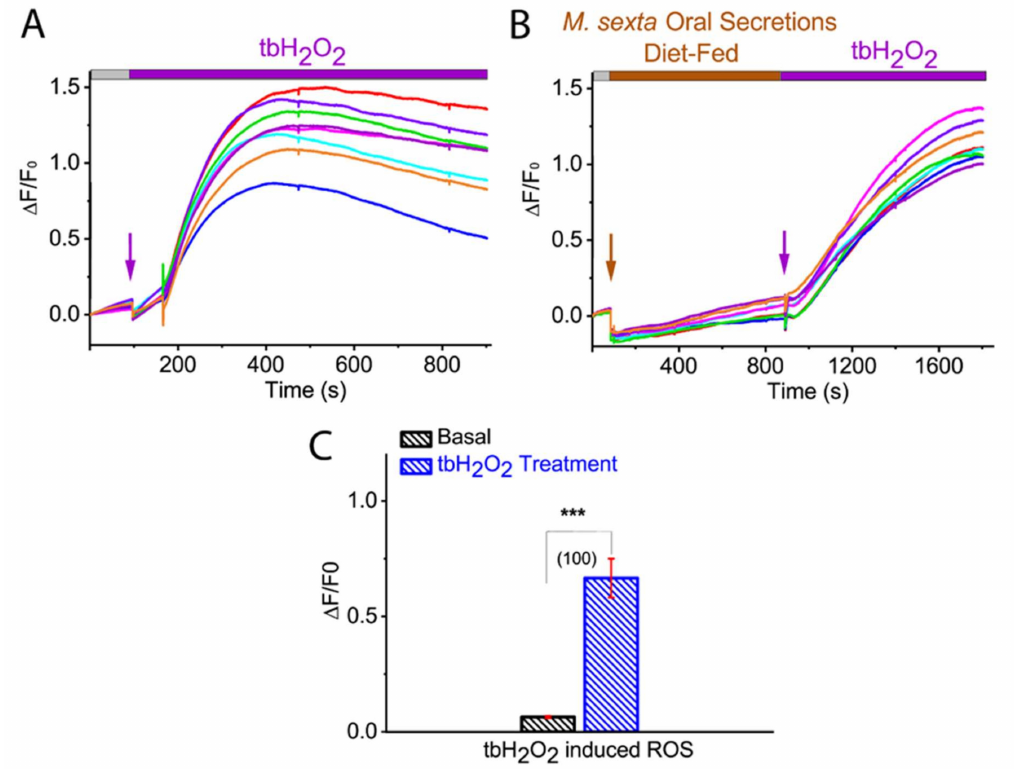
Figure 3. E ff ect of membrane-permeable oxidant tbH 2 O 2 on ROS production in tomato protoplasts. Representative ROS imaging of the isolated tomato protoplast with the application of membrane-permeable oxidant tbH 2 O 2 ( A ) and after application of diet-fed M. sexta OS ( B ). ( C ) Bar graph analysis of data shown in ( A ) illustrating maximum ROS generation after tbH 2 O 2 application. Statistical indicators reflect the non-parametric Mann-Whitney test, measuring for an e ff ect of tbH 2 O 2 on ROS production: *** p < 0.0001. Di ff erent color traces in the graph ( A , B ) reflect the OS-induced ROS response in individual protoplasts from a single replicate. The number of protoplasts ( N ) from 3–5 independent measurements are provided in parentheses in ( C